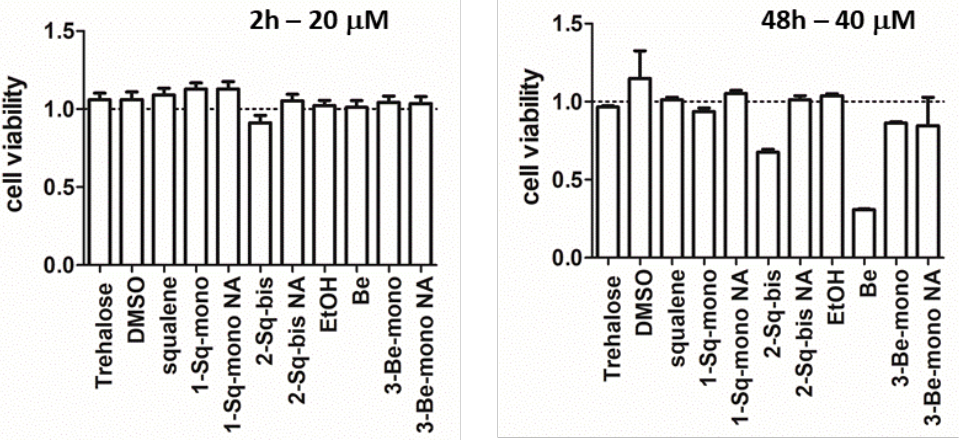
Figure 4. Cytotoxicity assay on betulinic acid, squalene, 1-Sq-mono, 2-Sq-bis , 3-Be-mono , mono-Sq-NA1 , bis-Sq-NA2 and mono-Be-NA3 . MTT assay, 2 h / 20 µ M ( left ) and 48 h / 40 µ M ( right ), trehalose = 100 mM.